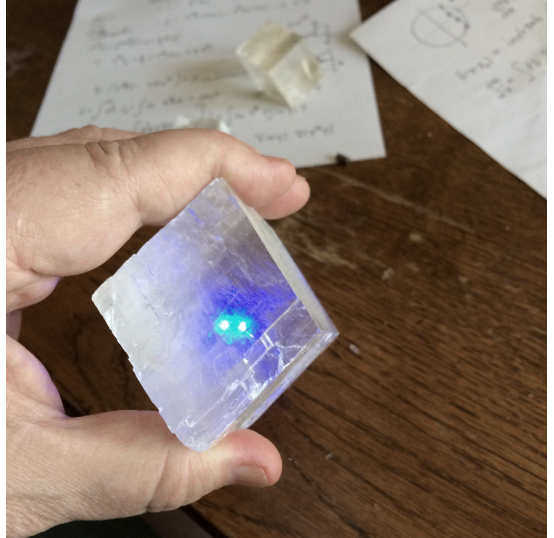
Figure 5. A single LED (light-emitting diod) light source is behind the calcite crystal in this paper author’s hand. The beam of light splits into two beams, using the same mathematical fact as in the Stern–Gerlach experiment. The experiment and the mathematics behind it were major clues to the polarization of matter waves, which has often been misinterpreted. Figure is taken from Ref.